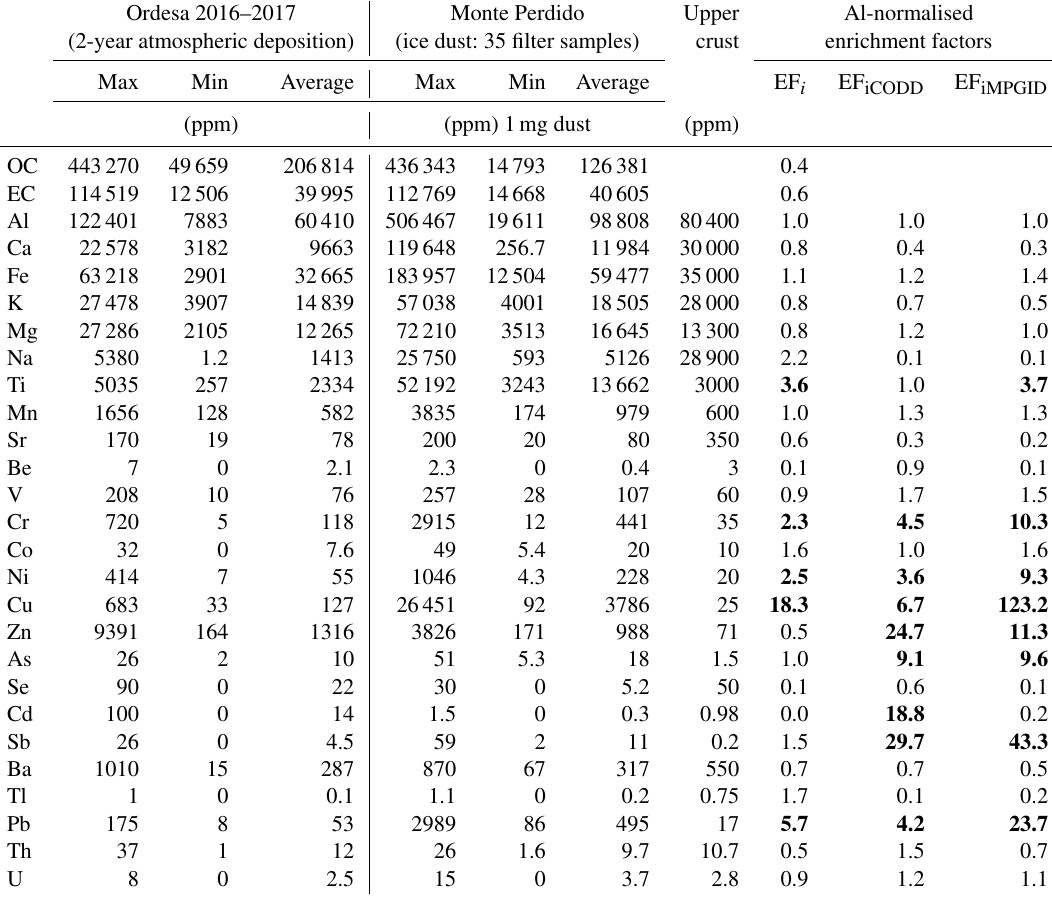
Table 4. Elemental concentration (ppm) of major and trace metals in both Ordesa’s current deposited dust and MPG ice deposits (averaged values for the 35 analysed samples), as well as upper-crust (UC) elemental contents for comparison (Taylor and McLennan, 1995). On the right side are Al-normalised enrichment factors (EFs) for dust components and elements for EF i , the MPG ice dust versus current Ordesa deposited dust (CODD); EF iCODD , the CODD versus the UC; and EF iMPGID , the MPG ice dust versus the UC. Numbers in a bold font in the EF represent anomalous values (elements enriched in Ordesa samples or in MPG